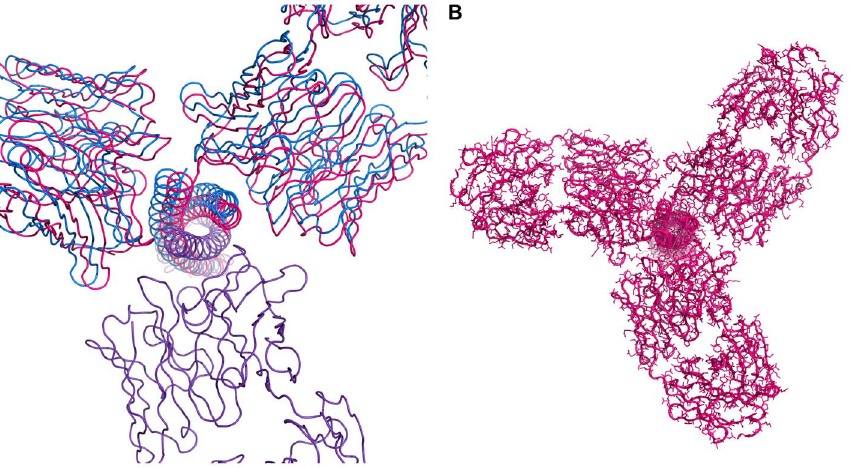
Figure 9. Different orientation of the Fab b -sheet frameworks in (Fab 8062) 3 /3-H complex in relation to the 3-fold axis of symmetry of 3-H are obligatory. (A) A single Fab of the (Fab 8062) 3 /3-H complex was superimposed on a corresponding Fab of (Fab 8066) 3 /3-H complex using the C a traces of the b -sheet of the variable domains (superimposed Fabs shown in purple), then (Fab 8062) 3 /3-H complexes were created using crystallographic symmetry operations of the Fab 8062 complex unit cell (shown in blue), or crystallographic symmetry operations of the Fab 8066 complex unit cell (shown in red). (B) (Fab 8062) 3 /3-H complex created using the crystallographic symmetry operations of the Fab 8066 complex unit cell shows multiple clashes between the side chains of the Fab 8062 (red) and 3-H (gray).